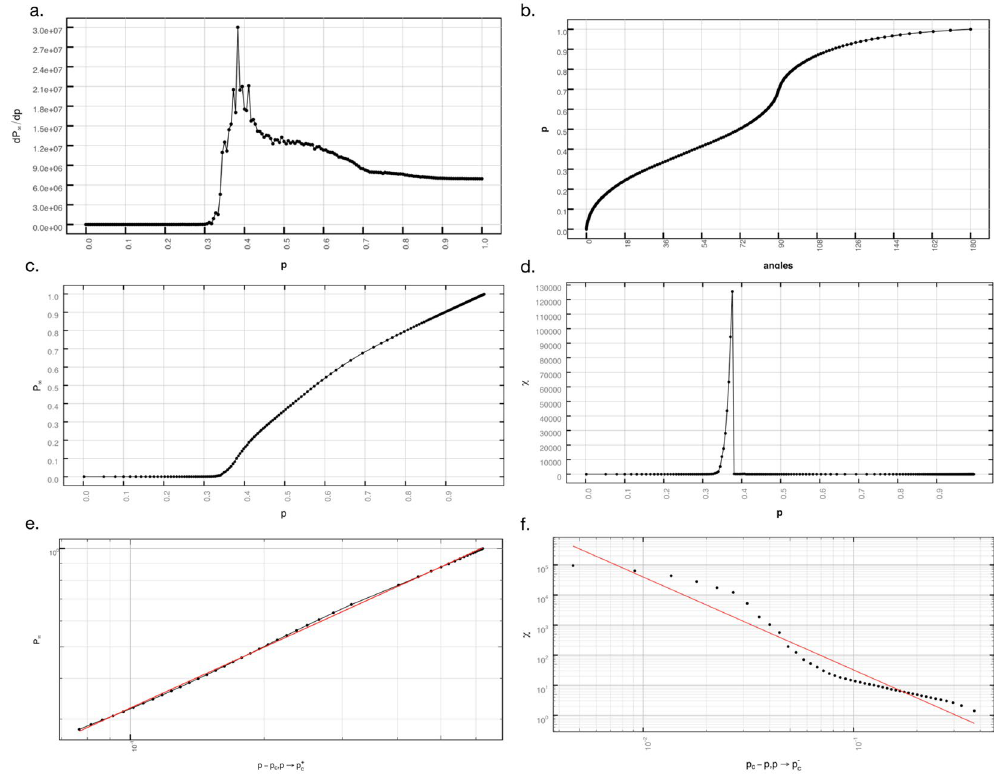
Figure 5. Critical behaviour of the UK road network: ( a ) derivative of the order parameter; ( b ) relationship between each angle and its cumulative probability of occurrence; ( c ) order parameter P ∞ ; ( d ) average cluster size χ ; ( e ) critical exponent β ; and ( f ) critical exponent γ